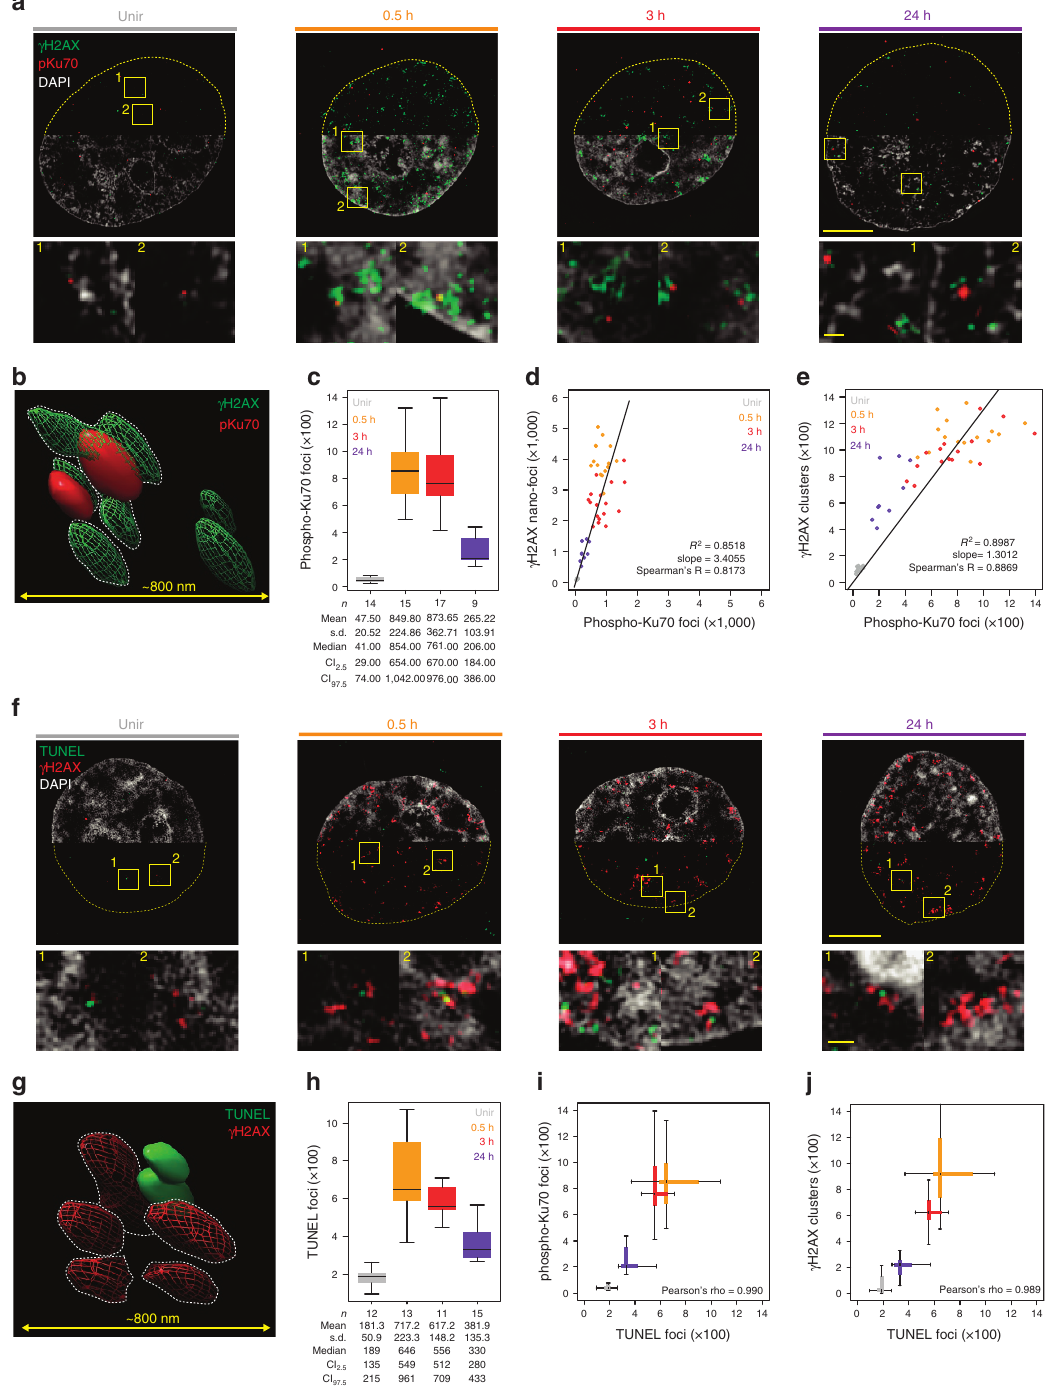
Figure 7 | Single phospho-Ku70- or TUNEL-labelled DNA DSBs are embedded in c H2AX clusters. ( a ) Exemplary 3D-SIM images of g H2AX and phospho-ku70 immunofluorescence before and during DDR. Shown are the mid-nuclear section (top) and enlarged views from the yellow frames (bottom). ( b ) 3D rendering of g H2AX and phospho-Ku70 immunostaining, 24h after IR. ( c ) Phospho-Ku70 foci number distributions before and during DDR, from 3D-SIM images (one-way ANOVA with Dunnett’s correction: P o 10 (cid:2) 3 ). Scatter plots of phospho-Ku70 foci and g H2AX nano-foci ( d ) or g H2AX clusters ( e ). Each dot represents a single-cell nucleus. ( f ) Exemplary 3D-SIM images of g H2AX and TUNEL immunofluorescence before and during DDR. Shown are the mid-nuclear section (top) and enlarged views from the yellow frames (bottom). ( g ) 3D rendering of g H2AX and TUNEL immunostaining, 24h after IR. ( h ) TUNEL foci number distributions before and during DDR, from 3D-SIM images (one-way ANOVA with Dunnett’s correction: P o 10 (cid:2) 3 ). Comparison between TUNEL and phospho-Ku70 ( i ) or g H2AX clusters ( j ) distributions, before and during DDR ( P o 10 (cid:2) 3 ). Scale bars, 5 m m and 500nm for main micrographs and magnified regions, respectively. All boxes and whiskers are as in Fig. 1. n : number of analysed cells. Results are from two independent